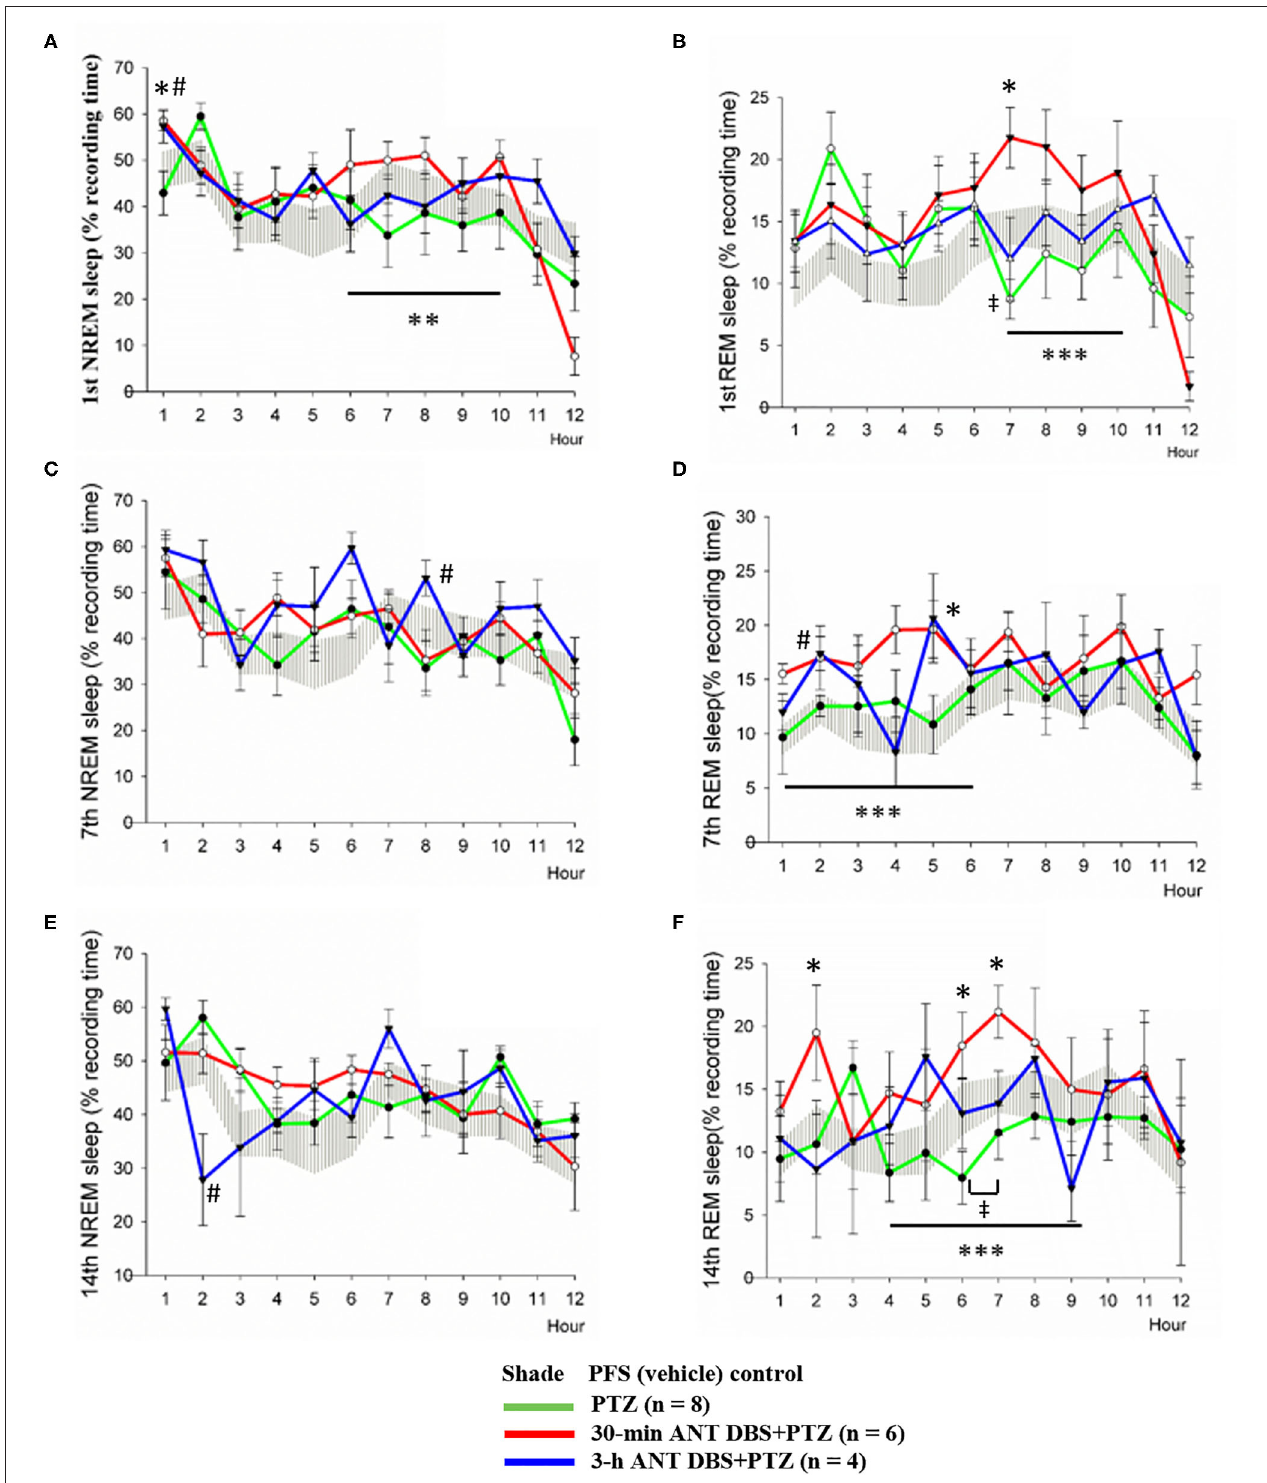
FIGURE 5 | Effects of pentylenetetrazol (PTZ) and anterior nucleus of thalamus (ANT) deep brain stimulation (DBS) on non-rapid eye movement (NREM) sleep and rapid eye movement (REM) sleep. (A) NREM sleep obtained after the vehicle injection, after the 1st pentylenetetrazol (PTZ) injection, after the 1st 30-min ANT DBS + PTZ, and after the 1st 3-h ANT DBS + PTZ. (B) REM sleep obtained before the PTZ injection, after the 1st PTZ injection, after the 1st 30-min ANT DBS + PTZ, and